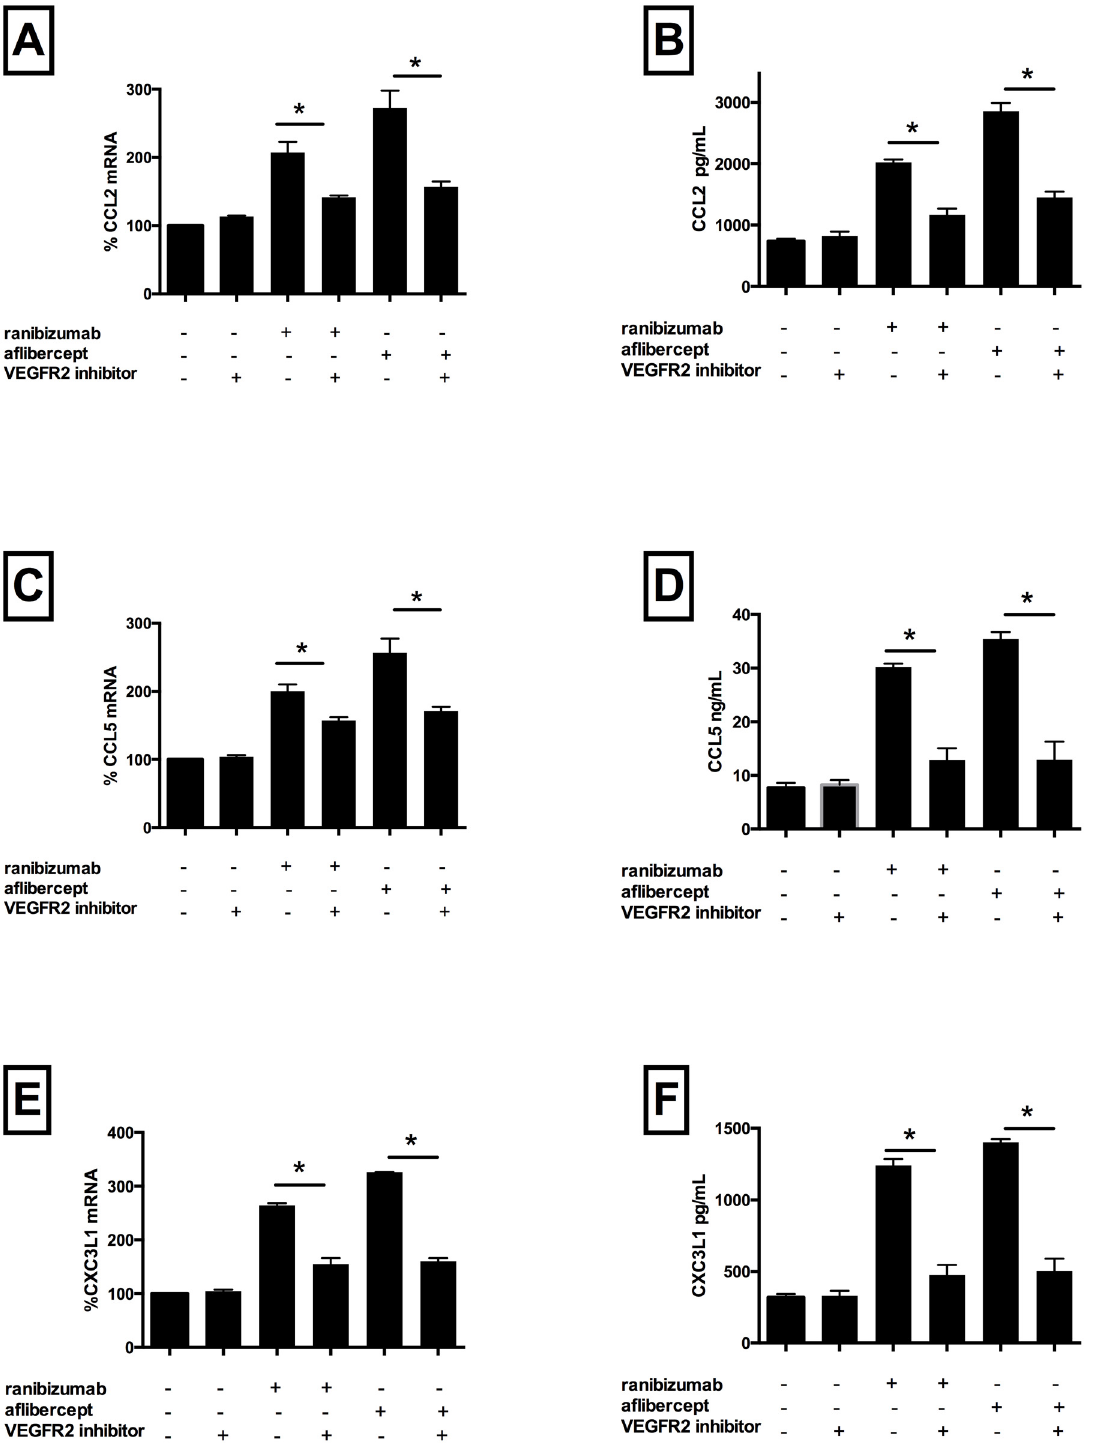
Fig 5. VEGFR2/VEGF-A ligand binding decreased ranibizumab and aflibercept mediated CCL2, CCL5, and CX3CL1 mRNA and protein levels in HCAECs. HCAECs were incubated with ranibizumab (0.1nM) or aflibercept (0.45nM), or PBS (control) and a VEGFR2 inhibitor for 16 h. Changes in CCL2, CCL5 and CXC3L1 (panels A, C and E) mRNA levels were quantified using real-time PCR. Protein levels (B, D, F) were quantified using ELISAs. Results are expressed as means +/- SEM. * P < 0.05 ranibizumab-treated cells vs. ranibizumab-treated VEGFR2 inhibitor treated cells; ** P < 0.05 aflibercept-treated cells vs. aflibercept treated VEGFR2 inhibitor treated